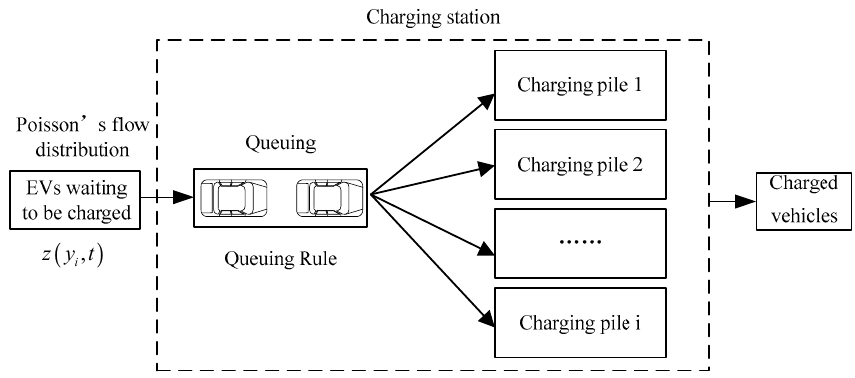
Figure A1. Queuing model of charging station based on the M/M/s model. FigureA1. Queuing model of charging station based on the M/M/s model. FigureA1. Queuing model of charging station based on the M/M/s model.